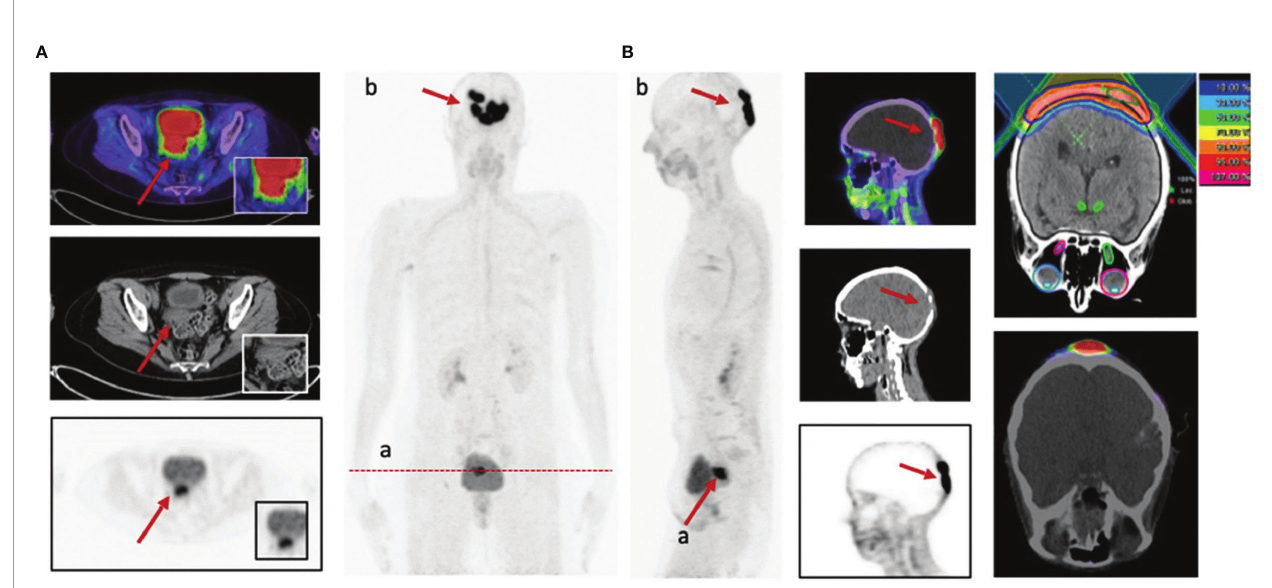
FIGURE 5 | A 58-year-old patient with cervical cancer underwent 68 Ga-FAPI-PET/CT staging prior to radiotherapy. recurrence of cervical cancer (SUVmax = 14.4) (A) . In addition, intracranial metastases showed strong FAPI uptake (SUVmax = 32.3) (B) , which allowed for precise delineation of radiotherapy target areas